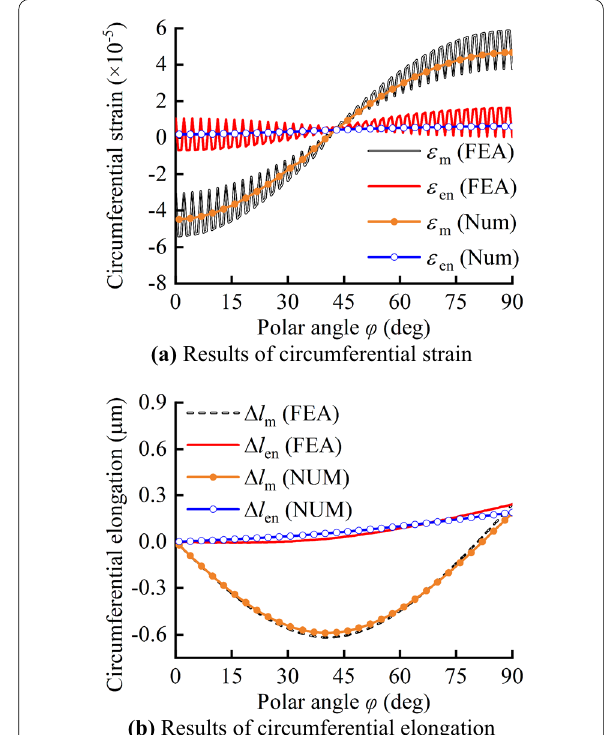
Figure 17 Circumferential strain and elongation of ring-shaped